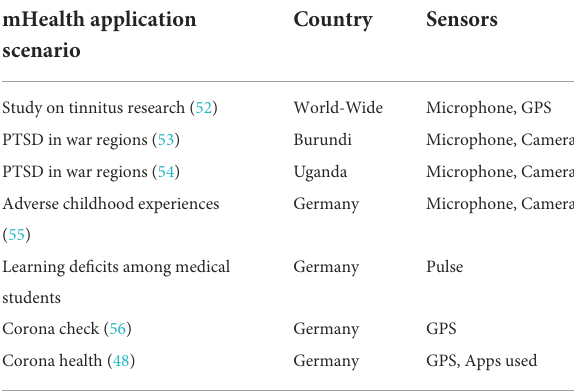
TABLE 1 Realized mHealth data collection